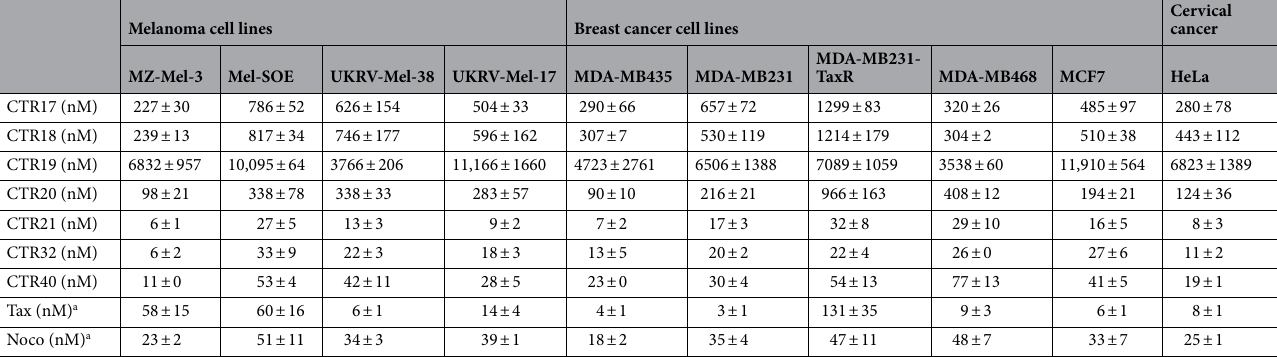
Table 1. GI 50 values of quinolone chalcone analogs on breast cancer, melanoma and cervical cancer cells. GI 50 values were derived from a non-linear sigmoidal dose–response (variable slope) curve fitted by GraphPad Prism v.4.03 software. a Tax and Noco denote paclitaxel and Nocodazole, respectively.